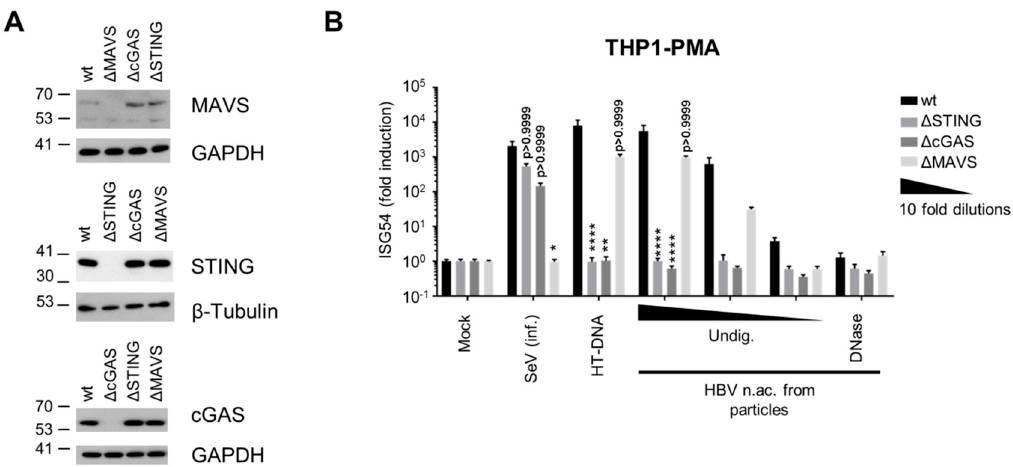
Figure 2. HBV DNA is sensed by the cGAS / STING pathway. ( A ) Genome editing of THP1 CRISPR / Cas9 KO for STING, cGAS or MAVS was controlled by Western Blot. ( B ) PMA-di ff erentiated WT or KO THP1 cells were infected with SeV, transfected with HT-DNA (5 pg / cell) or with serial dilutions of undigested (Undig.) or DNAse-digested HBV nucleic acids (n.ac.) from particles. ISG54 mRNA fold induction to the mock was determined by RT-qPCR 24 h post-transfection. Average and SEM of three independent experiments in triplicates are shown. **** p < 0.0001, ** p < 0.01 and * p < 0.05 (Kruskal–Wallis test with Dunn’s test; for each stimulus, the knock-out cells are compared to the WT cells).